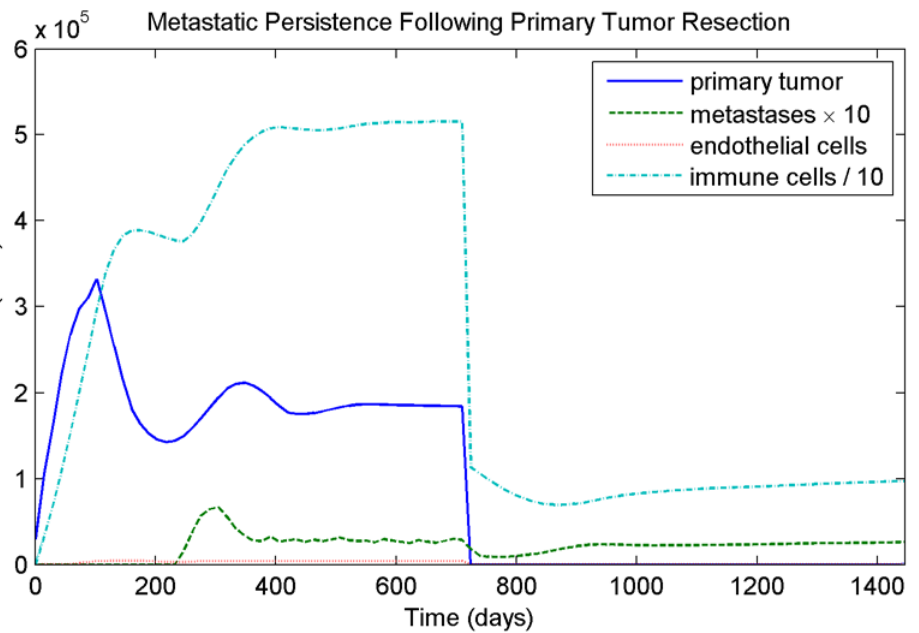
Figure 9. Resection of a strongly immunogenic tumor followed by low-level metastatic persistence. In this case, the immune response holds the metastatic load to a total mass much less than that of the primary tumor, and unlike in the cases shown in Figures 7 and 8, resection of the primary tumor does not induce growth in these metastases. However, a small but biologically relevant metastatic load remains, suggesting that dormant metastases can persist nearly indefinitely and may be sensitive to future perturbations of the system.